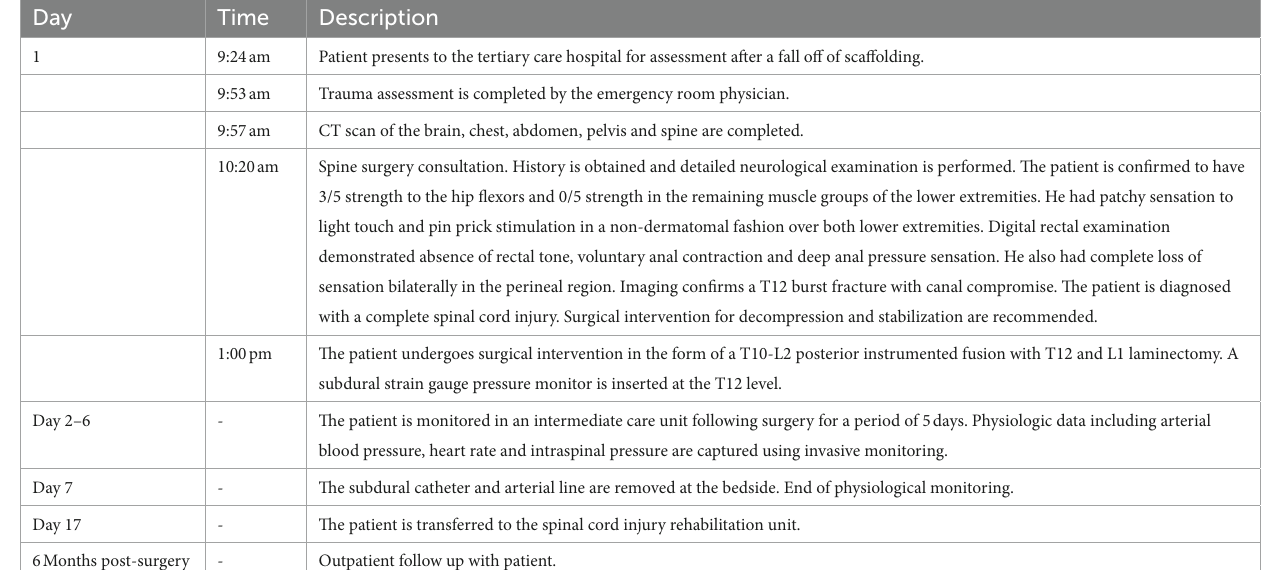
TABLE 1 Time course of events for examination, imaging and intervention on a patient with an acute traumatic spinal cord injury. Day Time